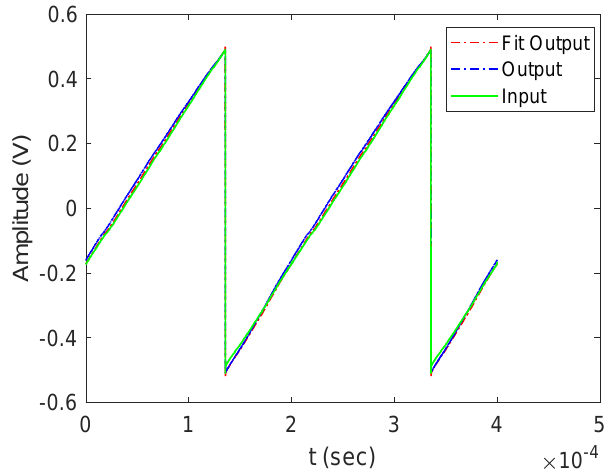
Figure 13. Measured and fitted sawtooth response with six transformers connected in series, γ = 6 and R IN = 4.7 Ω in Figure 8 and Equation (9), superimposed onto a 5 kHz input signal. Fitted and measured signals are indistinguishable. Signals are normalized in amplitude.